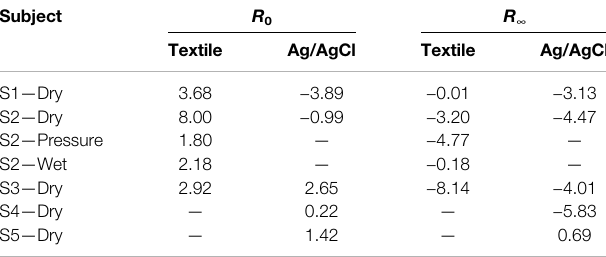
See Delano and Sodini (2018a) for a detailed derivation.